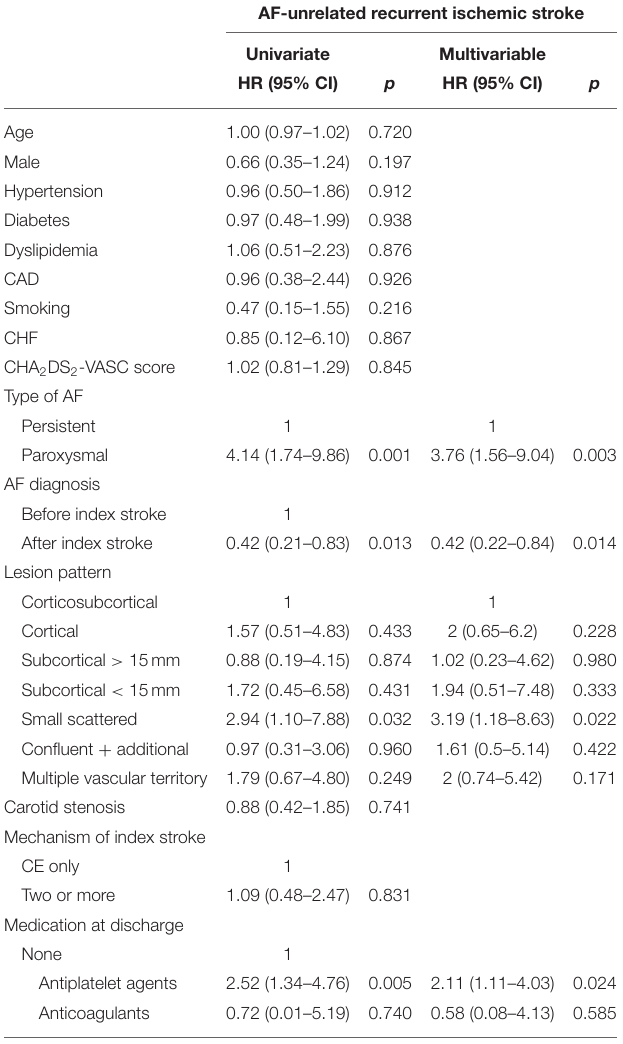
TABLE 3 | Univariable and multivariable analyses of factors predictive of AF-unrelated stroke recurrence. AF-unrelated recurrent ischemic